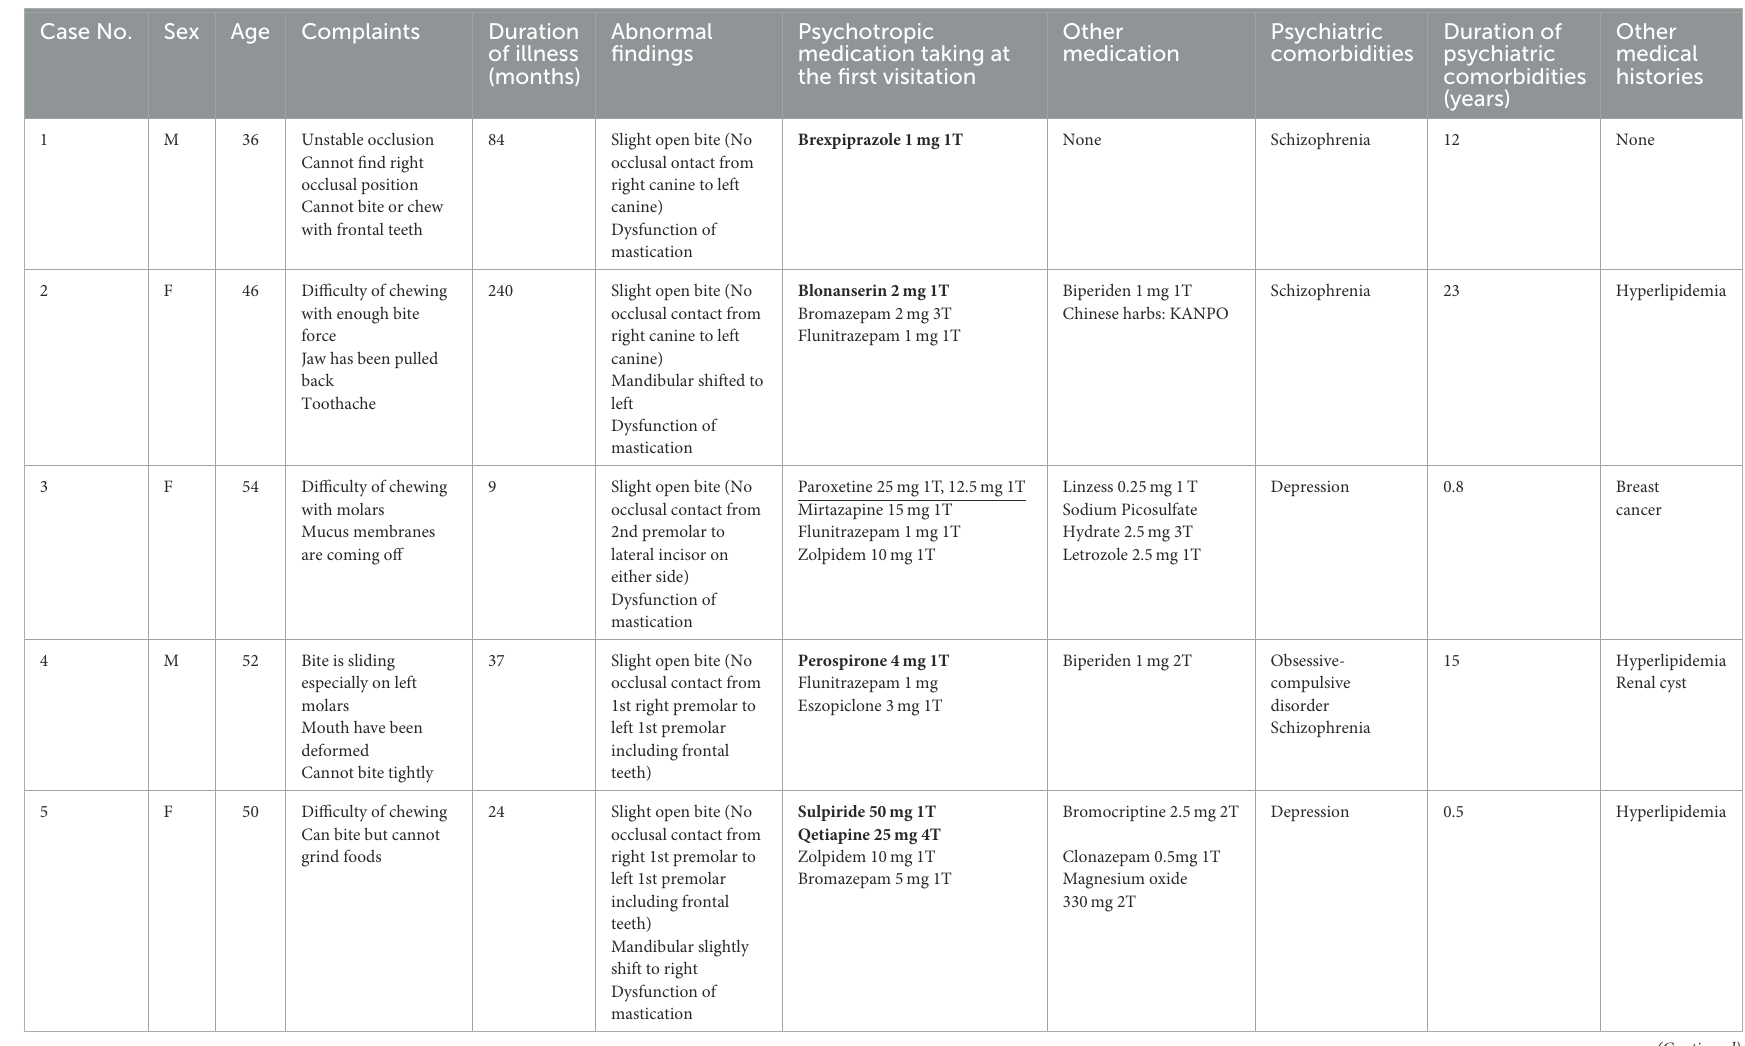
TABLE 1 Cases with drug-induced open bite. Case